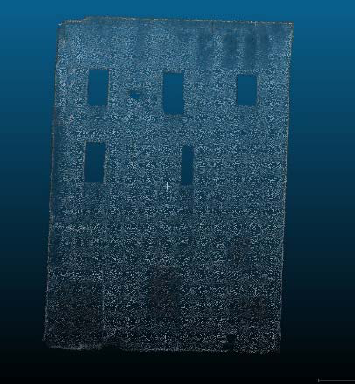
Figure 7: UAV Photoscan processing